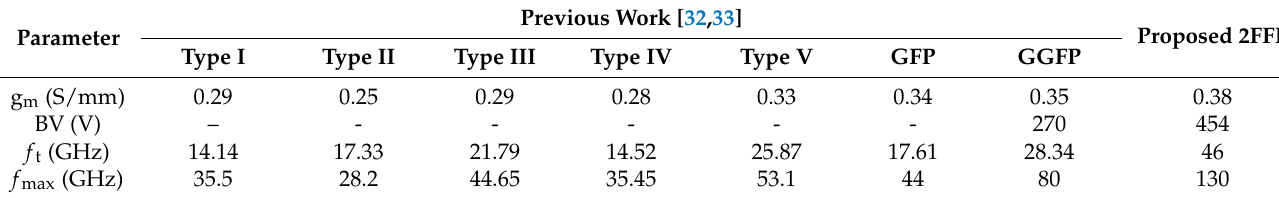
Table 3. Summary of the device performance parameters of this work compared with previous